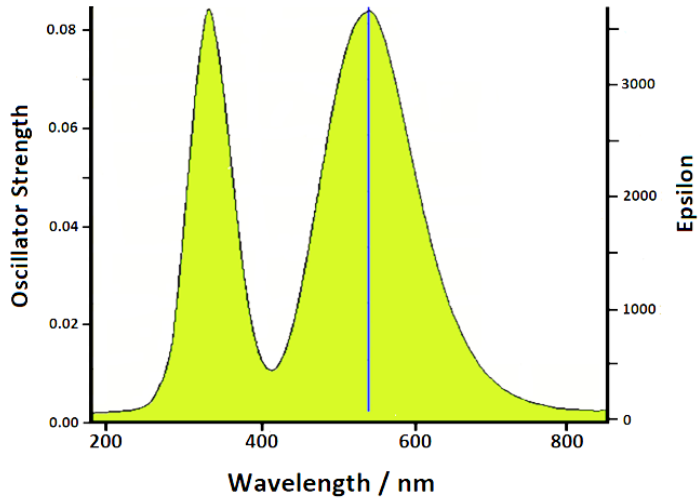
Figure 6. Calculated excitation spectrum of Anion-Ag + equatorial complex.